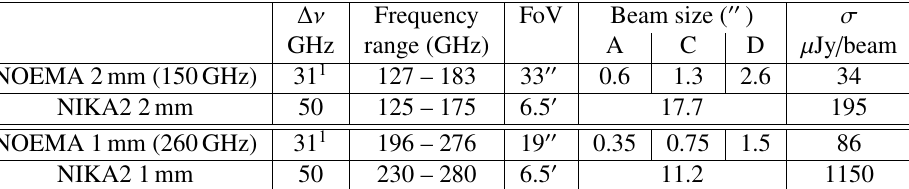
Table 1. NOEMA and NIKA2 specifications for a single pointing. Numbers below do not take into account fast mapping capabilities of NIKA2. NOEMA beam sizes are indicated for the three array configurations currently available (extended: A, intermediate: C, compact: D). σ is the point source continuum sensitivity obtained after one hour on source. More details are given in Sect.